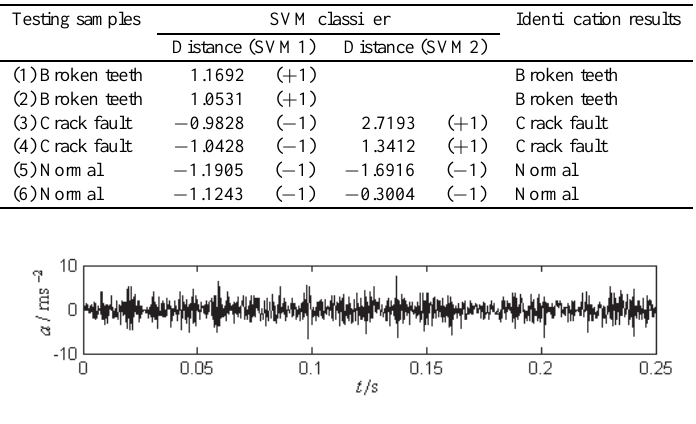
Fig. 7. The vibration acceleration signal of a normal roller